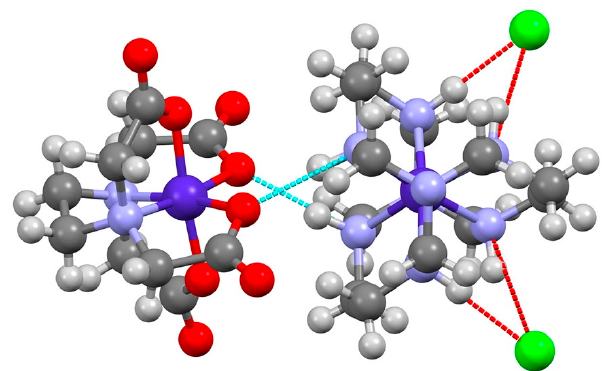
Figure 3. Hydrogen bonding between ∆ -[Co(sep)] 3+ and Λ -[Co(edta)] − . The view is down the molecular C 3 -axis of [Co(sep)] 3+ and shows the interaction with Cl − on the molecular C 2 -axes. Bond distances for complexes (Å): Co-N ( ∆ -[Co(sep)] 3+ ) 1.973(3), 1.974(3) 1.979(3) 1.987(3) 1.987(3) 1.993(3); Co-N ( Λ -[Co(edta)] − ) 1.921(3), 1.930(3); Co-O (G-ring) 1.898(3), 1.911(3); Co-O (R-ring) 1.879(3),